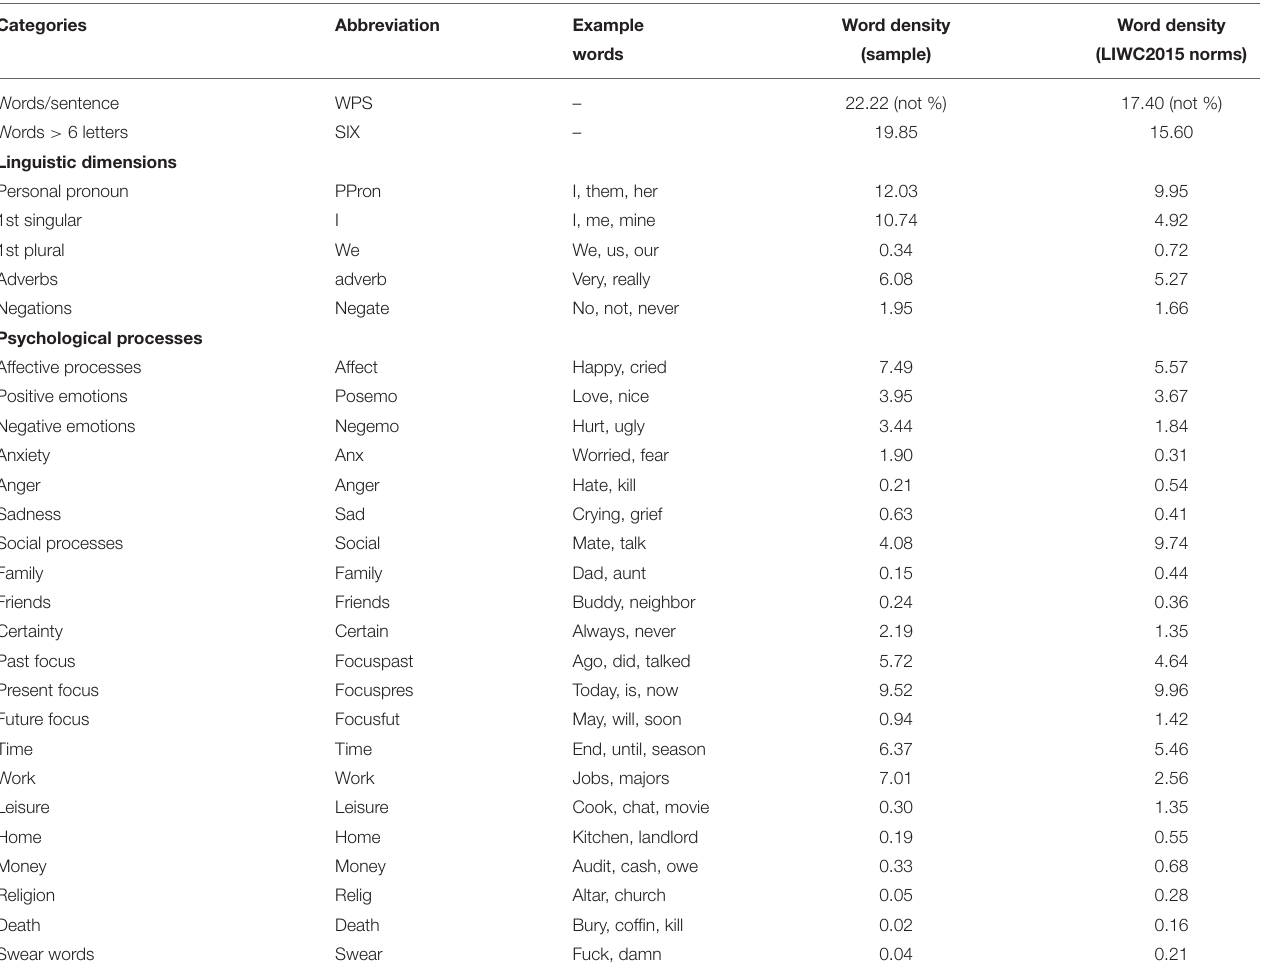
TABLE 1 | Language Inventory Word Count (LIWC) categories in the present study.